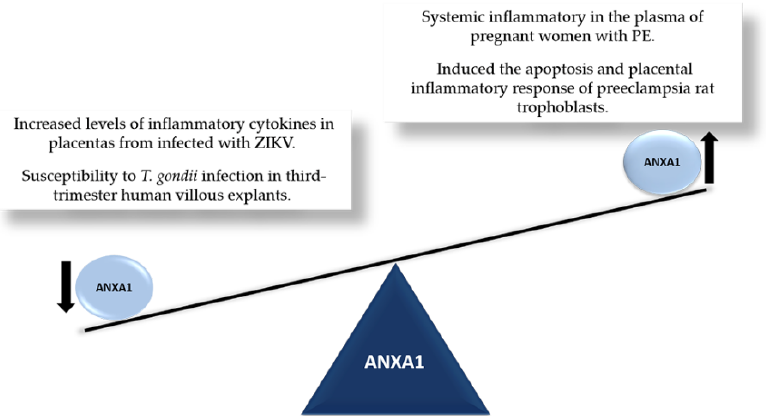
Figure 1. ANXA1 in the placenta. Representation of imbalance in ANXA1 levels in placentas at high-risk in pregnancy: ZIKV [53], T. gondii [52] and preeclampsia [59,62].